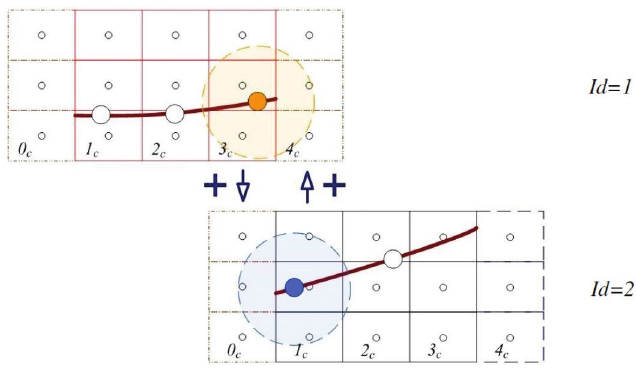
Figure 4 - Correct distribution of Lagrangian forces in a parallel approach. Step